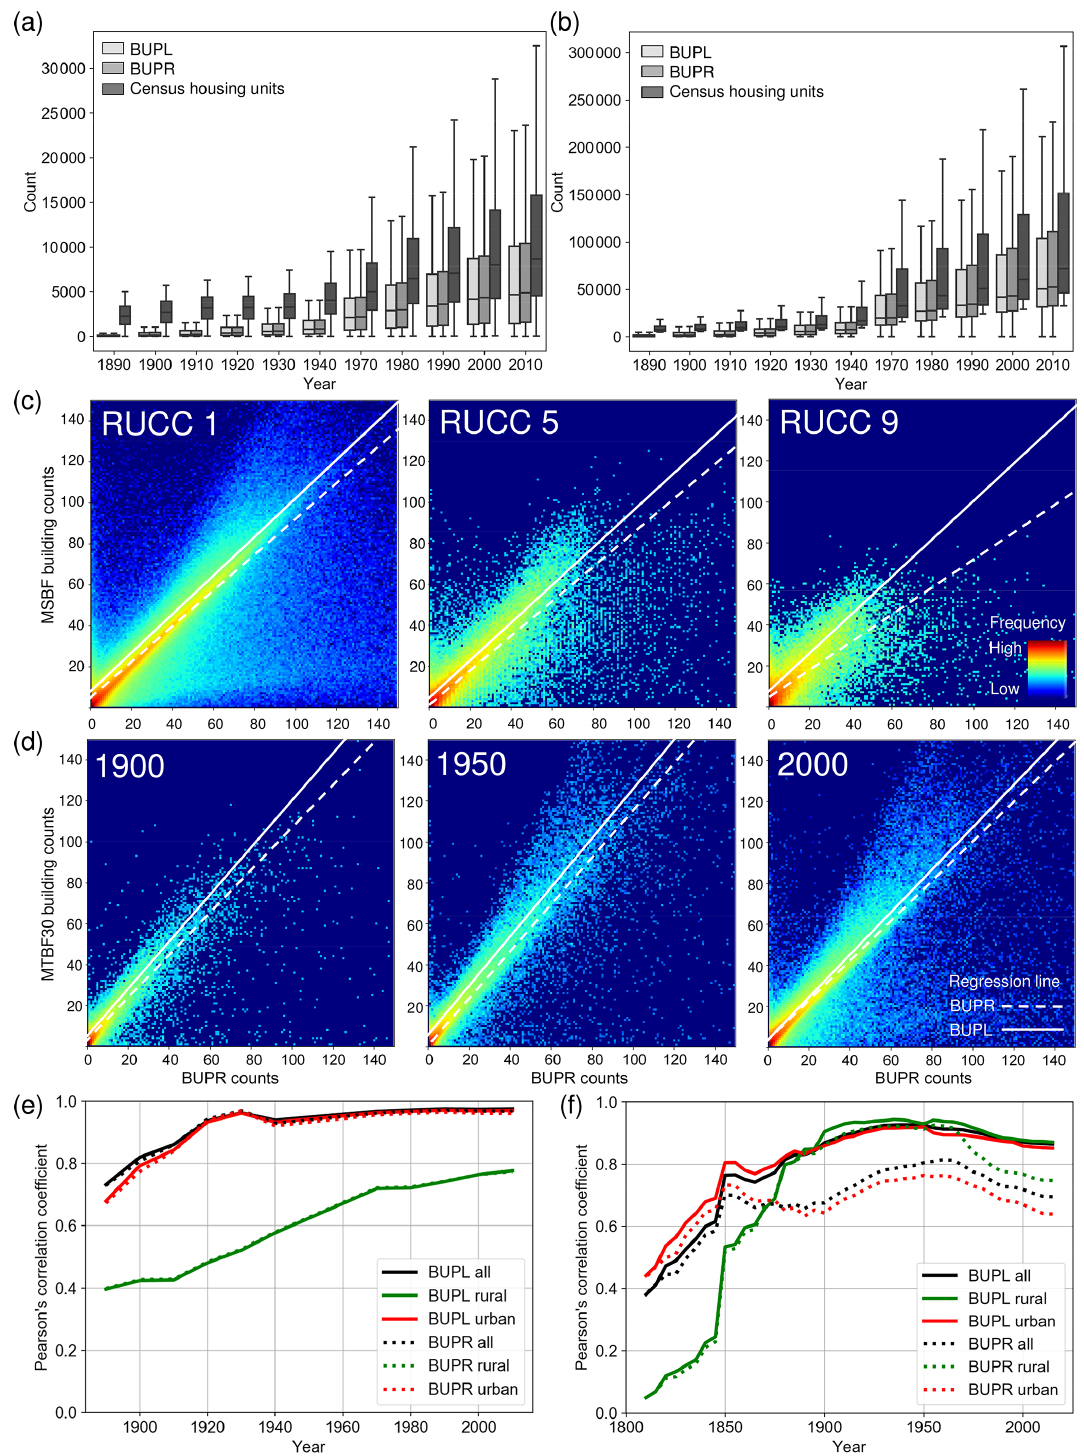
Figure 11. Results of the quantity agreement analysis: US-wide trends of housing development from 1890 to 2010 according to US census data and BUPR-derived trajectories for strata of (a) rural and (b) urban counties (separated by the 75th percentile of the decennial census data distributions); (c) grid-cell-wise quantity agreement between test data and MSBF data in 2016, shown for counties of USDA RUCCs 1 (urban), 5 (intermediate), and 9 (rural); (d) multi-temporal trends of quantity agreement with building counts derived from MTBF30 in 1900, 1950, and 2000; and time series of Pearson’s correlation coefficients for county-level BUPR–BUPL summaries (e) against US census housing unit counts and (f) against the multi-temporal building footprint reference database at the 250m grid cell level. Panels (c) and (d) also show a regression line obtained from robust linear